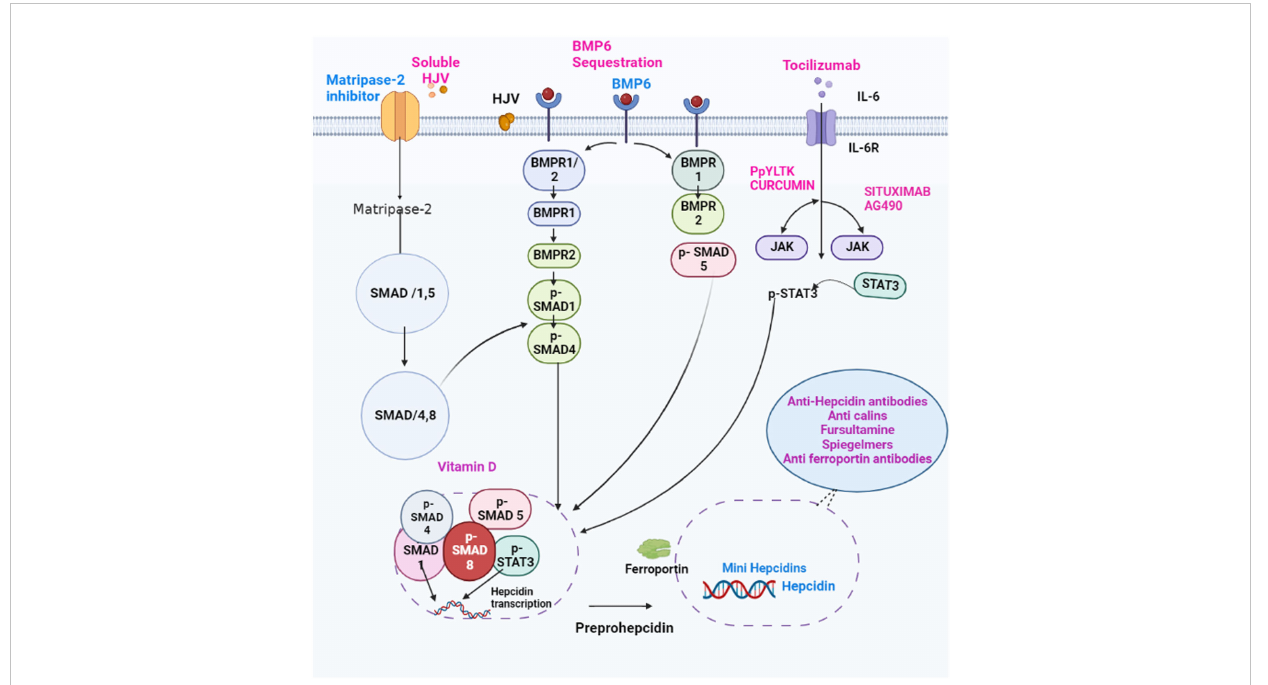
FIGURE 3 Schematic representation of therapeutic treatments targeting hepcidin. Hepcidin antagonists (Pink). Mediators that inhibit hepcidin expression, anti- hepcidin antibodies, or substances that interfere with the interaction between hepcidin and ferroportin. Hepcidin agonists (Blue) Hepcidin analogues and other agents that boost expression of the protein